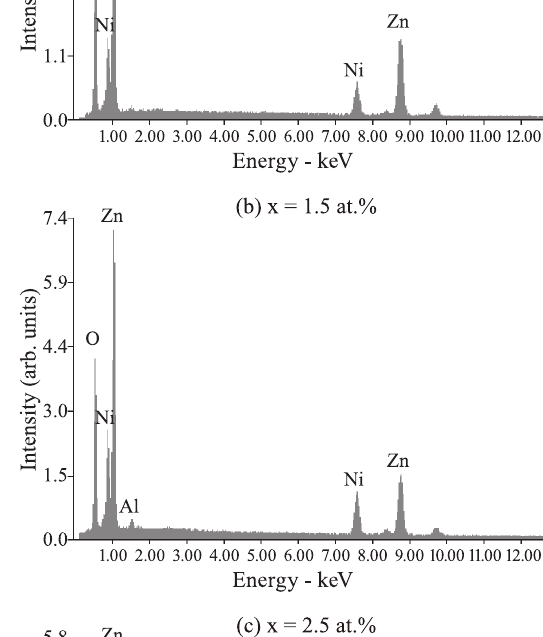
Fig. 2 XRD patterns of the three Zn 0.9-x Ni 0.1 Al x O nanopowder samples synthesized by the sol-gel method: (a) x = 0 at.%, (b) x = 1.5 at.% and (c) x = 2.5 at.%.